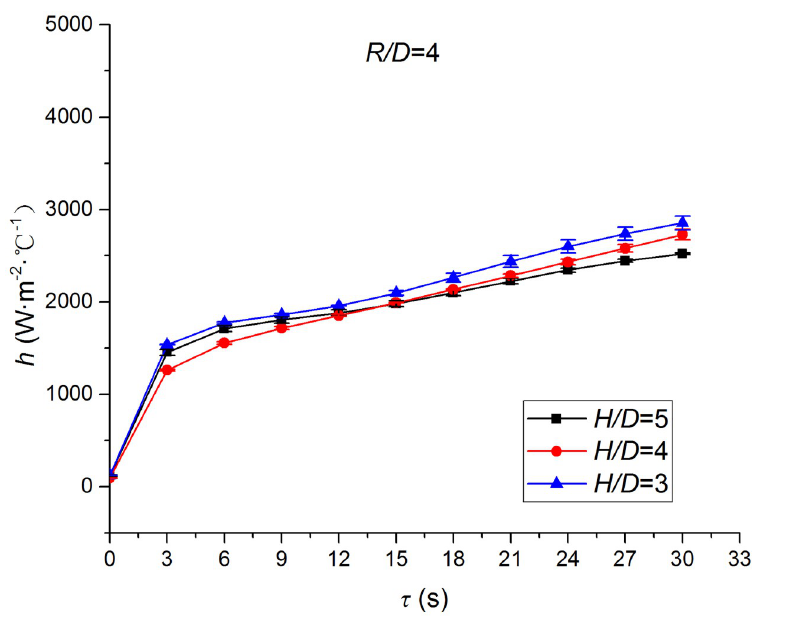
Fig 30. Convective heat transfer coefficient at R/D = 4.